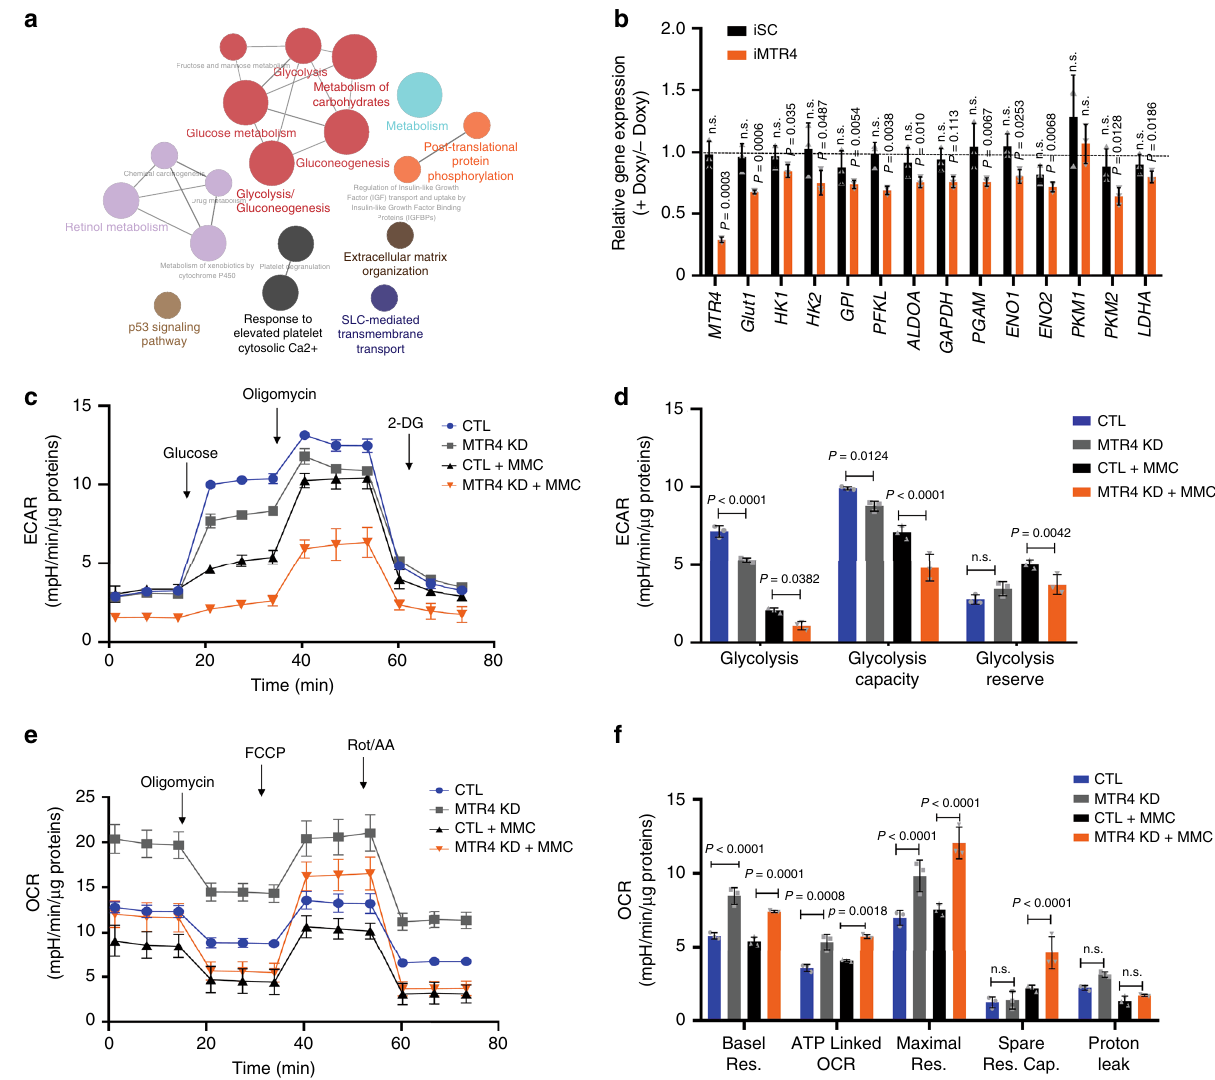
Fig. 2 MTR4 is required for glycolysis of HCC cells. a Global gene expression analysis of iMTR4 cells before and after Doxy treatment identi fi ed differential expressed genes (DEGs), which were enriched in various pathways with pathway analysis and visualized as the overlap graph. b The mRNA levels of glycolytic genes in iSC and iMTR4 cells before and after Doxy treatment. Two-tailed, paired t -test. Data are presented as mean value ± s.d. p value is indicated. n.s., non-signi fi cant. n = 3 biologically independent samples. c , d Extracellular acidi fi cation rate (ECAR) in control cells and MTR4 KD cells with either MMC (5 µ g/ml) or DMSO as a solvent control in response to glucose (10 mM), oligomycin (1 μ M), and 2-DG (50 mM). n = 3 independent experiments. Data are presented as mean value ± s.d., two-way ANOVA with a Tukey ’ s multiple comparison test. p value is indicated. e , f Oxygen consumption rate (OCR) in control cells and MTR4 KD cells with either MMC or DMSO as a solvent control in response to oligomycin (1 μ M), fl uorocarbonyl cyanide phenylhydrazone (FCCP, 1.5 μ M), rotenone/antimycin A (Rot/AA, 0.5 μ M). n = 3 independent experiments for each group. Data are presented as mean value ± s.d., two-way ANOVA with Tukey ’ s multiple comparison test. p value is indicated. Res., respiration; Cap, capability. Source data are provided as a Source Data fi motifs of the pre-mRNA (Fig. 4j, k). In addition, similarly to the PKM minigene to PKM2 , suggesting that PTBP1 is involved in impact of MTR4 knockdown, the mutation of the MTR4 MTR4-dependent splicing events (Fig. 5c). In support of this binding motifs within the minigenes led to increased splicing of notion, co-immunoprecipitation experiments indicate that MTR4 the pre-mRNAs transcribed from the minigenes to GLUT1b interacts with PTBP1 in a RNA-independent manner (Fig. 5d). In and PKM1 isoforms respectively, indicating that the binding of contrast, MTR4 interacts with another RNA-binding protein MTR4 to its target pre-mRNA is required for its function in AS hnRNPA1 in a RNA-dependent manner (Fig. 5d). Therefore, (Fig. 5a, b). MTR4 might recruit PTBP1 to its target pre-mRNAs through protein – protein interaction. In further support of this notion, the mutation of the MTR4 binding motifs within the PKM minigene signi fi cantly reduces the binding of PTBP1 to the pre-mRNA transcribed from the minigene (Fig. 5e). In summary, these data minigene to PKM2 isoform in HCC cells, the silence of PTBP1 demonstrate that MTR4 regulates AS of its target genes by in HCC cells inhibits the AS of the pre-mRNA transcribed from recruiting PTBP1 to the target pre-mRNAs.